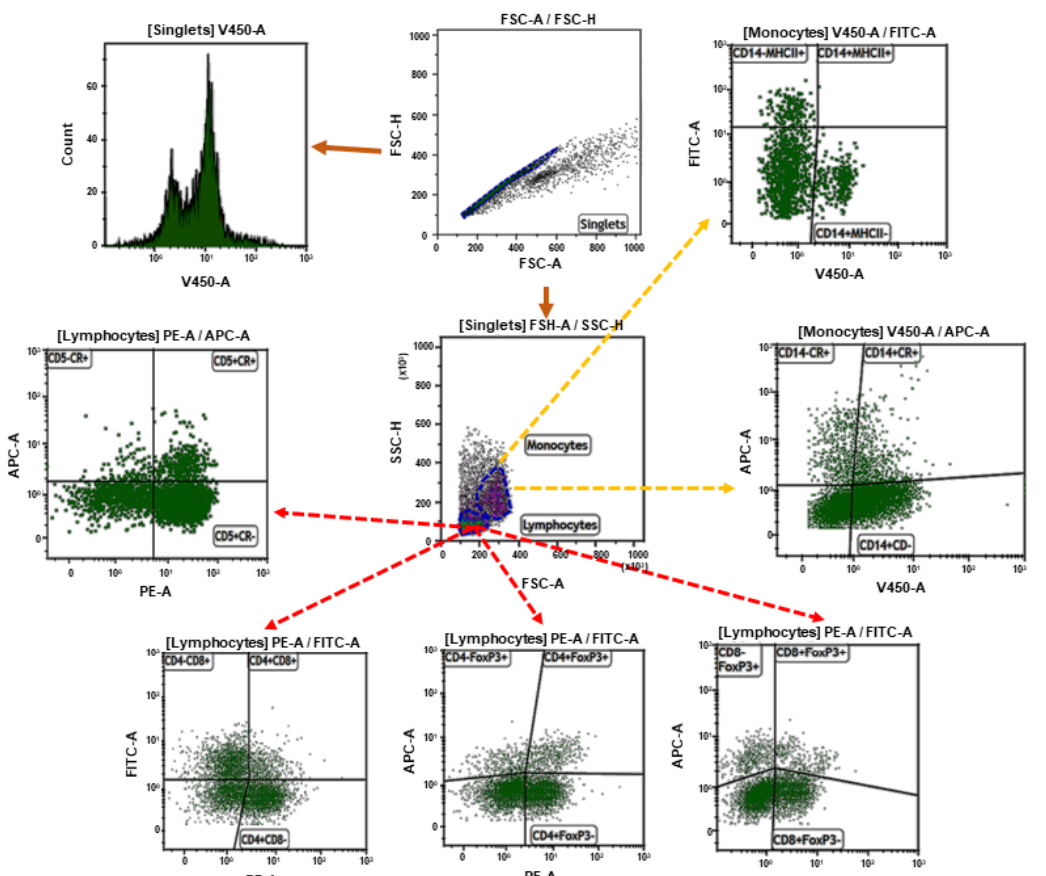
Figure 1. The gating strategy. Doublets were removed from the analysis by setting the gate on single cells on the FSC-area (FSC-A) vs. FSC-high (FSC-H) dot plot. Cell proliferation was calculated from singlets. Next, the lymphocytes or monocytes were gated based on FSC and SSC dot plots. Then the gate included lymphocytes and analysis of CD4 + , CD8 + , and FoxP 3 cells were made. The second sample included CD5 + , CD14 + , MHCII + cells, and the median fluorescence intensity (MFI) of ROS was calculated on that cell